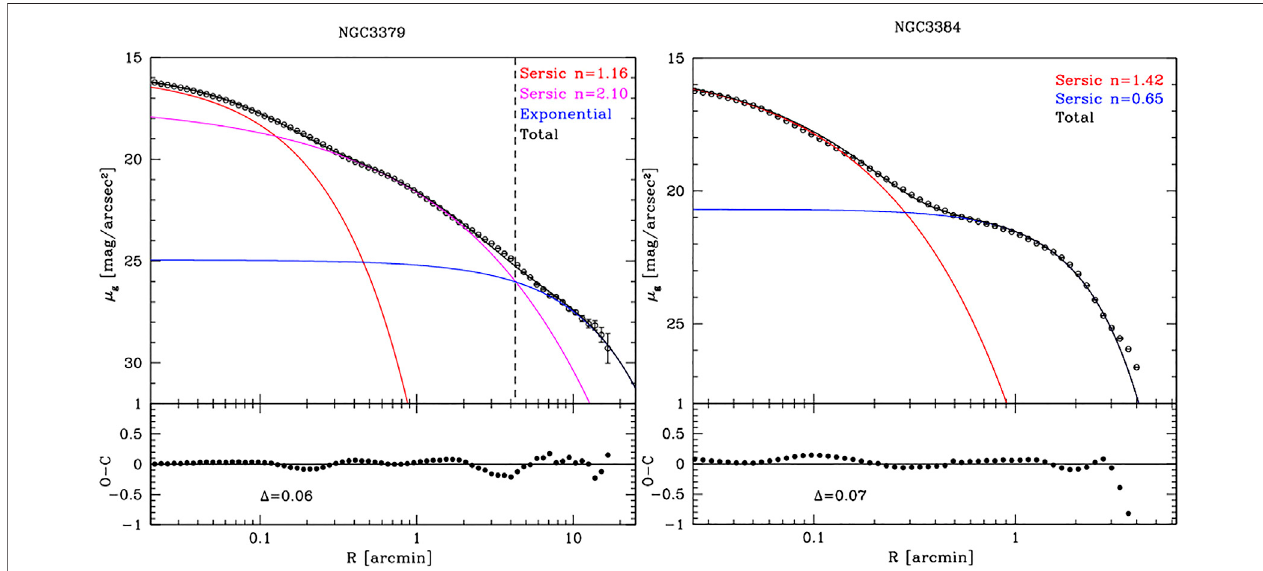
FIGURE5| Leftpanel (Top panel) Three componentsmodel ofthe azimuthally averaged surfacebrightnesspro fi le ofNGC 3379outto ~57kpc in g band. The red and magenta lines indicate a fi t to the inner region with a two Sérsic pro fi les. The blue line indicates a fi t to the outer diffuse component (IGL) and the black line indicates the sum of the components in each fi t. The vertical dashed line shows the estimated value for R tr (~ 12.5 kpc).(Bottom panel) Δ rms scatter of the data minus the model (seetextfordetails). Rightpanel (Toppanel)Twocomponentsmodeloftheazimuthallyaveragedsurfacebrightnesspro fi leofNGC 3384outto~12kpcin g band. The red and blue lines indicate a fi t to the inner region with a two Sérsic pro fi les. The black line indicates the sum of the components in each fi t. (Bottom panel) Δ rms scatter of the data minus the model (see text for details).